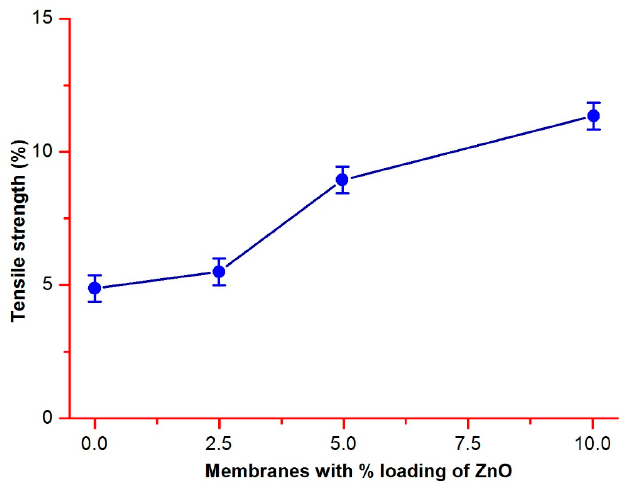
Figure 10. Mechanical Strength of the various prepared membranes.